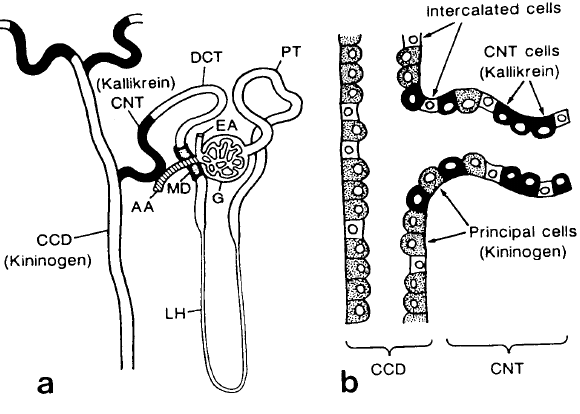
Figure 1. (a) Diagram of the immunocytochemical localization of kallikrein and kininogen in the human nephron and (b) a schematic representation of the intermingled CNT cells and principal cells at the junction between CNT and CCD. AA, afferent arteriole; CCD, cortical collecting duct; CNT, connecting tubule; DCT, distal convoluted tubules; EA, efferent arteriole; G, glomerulus; MD, macula densa; LH, Loop of Henle: PT, proximal tubule. (reproduced from Ref. [13] with